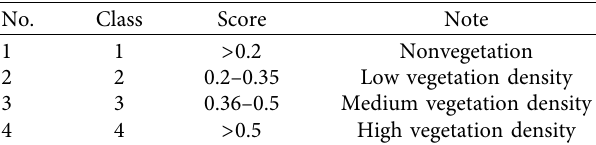
Figure 2: Changes in the built-up area density in Banjarmasin City in 2015 and 2019. Table 1: NDVI classifcation based on vegetation